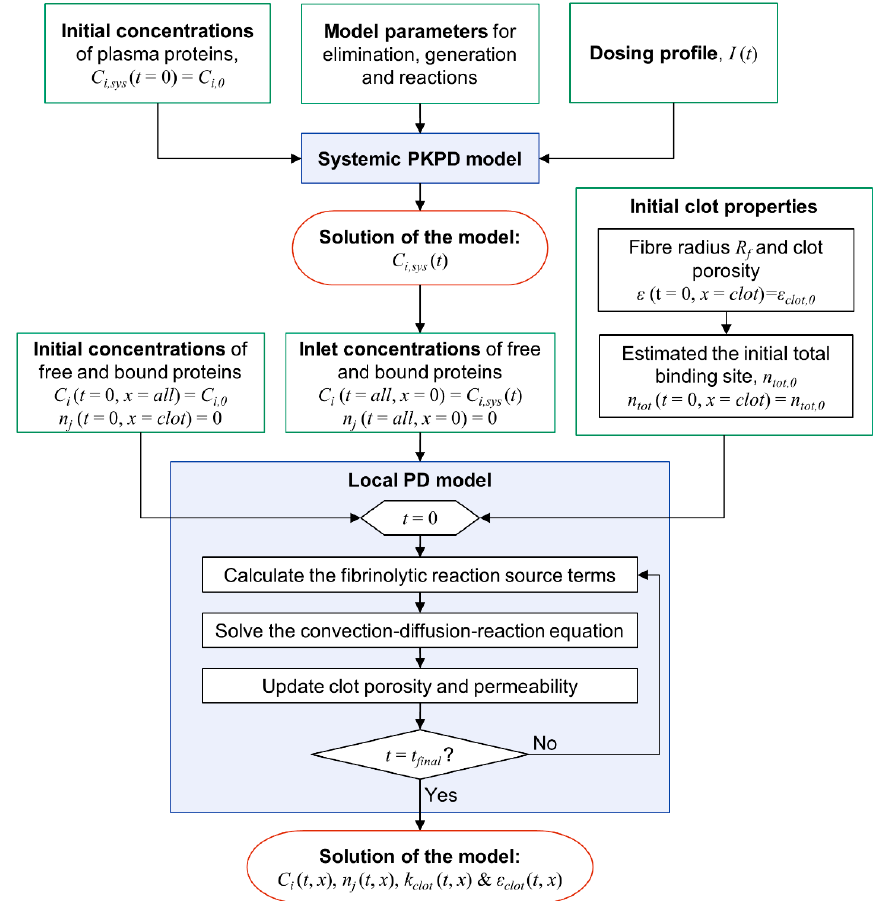
Figure 3. Flow chart of the solution procedure for the systemic and local models. Input information required for solving each model is specified in the green boxes.